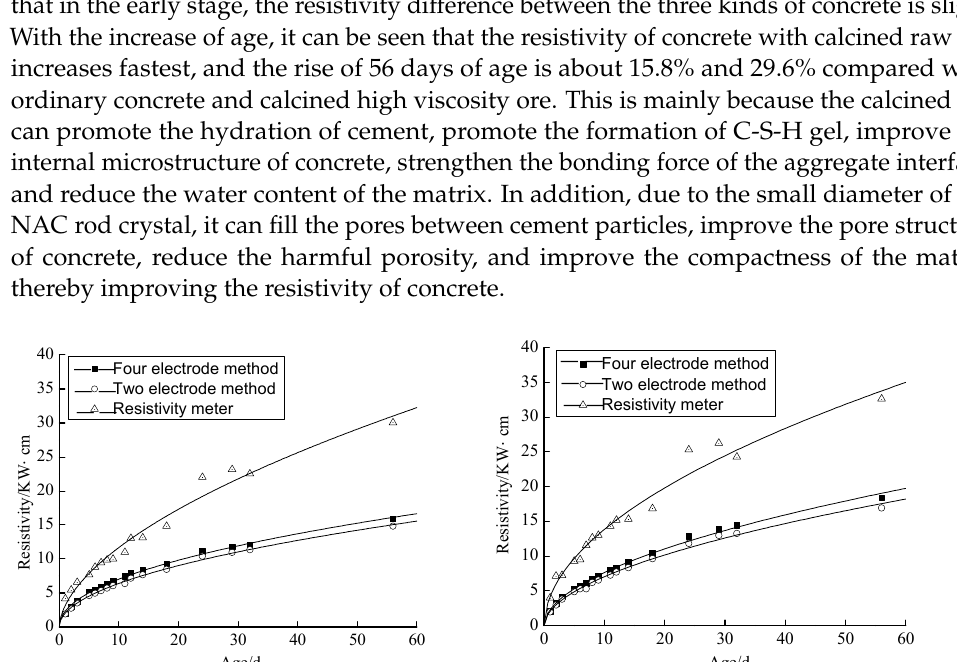
Figure 16. The resistivity of concrete by four-probe method. 3.4.2. Effect of Concrete Resistivity on Chloride Diffusion Coefficient The experiment is to force the chloride ion to migrate to the anode under the action of electric field force, and the resistivity of the specimen is crucial to the chloride ion dif- fusion. For porous material concrete, the relationship between chloride diffusion coeffi- cient and resistivity of concrete can be reflected by the Nernst-Einstein equation, as shown in Equation (10):